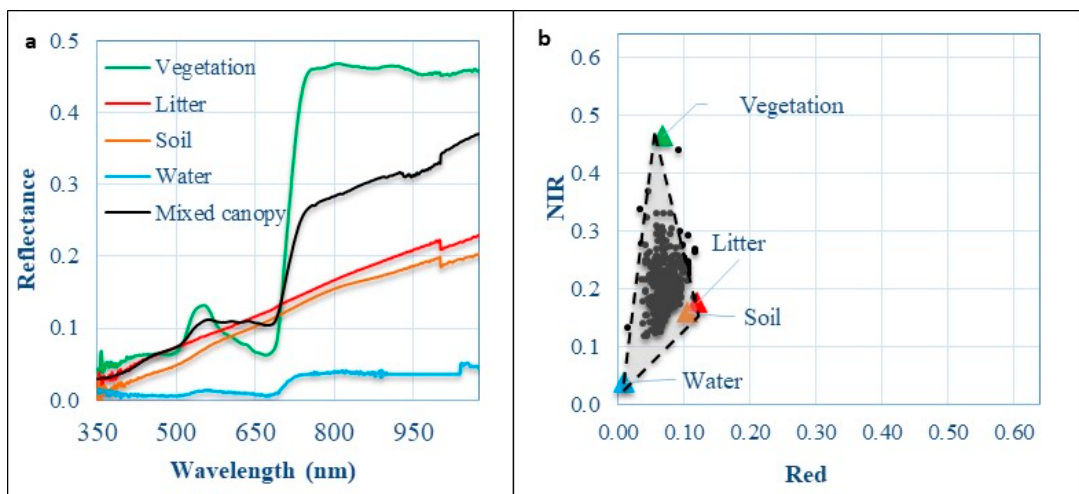
Figure 3. Flowchart of methodology. Remote Sens. 2020 , 12 , x FOR PEER REVIEW